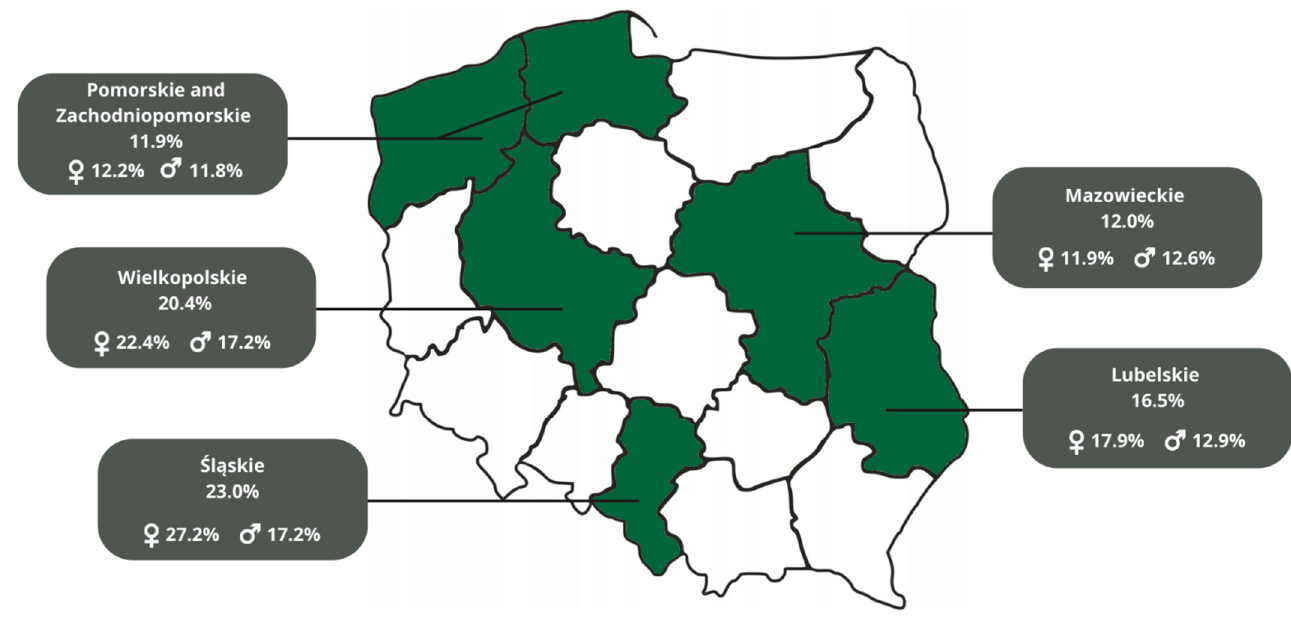
Figure 1. HPV vaccination level in Poland among adolescents in the POLKA 18